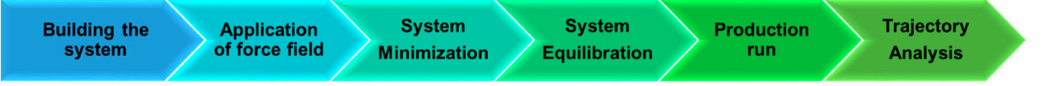
Figure 4. Typical molecular dynamics simulation